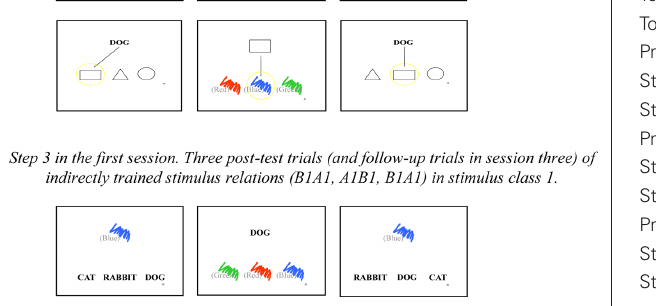
“*” Indicates when students with symbolic behavior scored significantly higher when comparing to students with non-symbolic behavior. “¤” Indicates a significant difference from the tabulated value above.